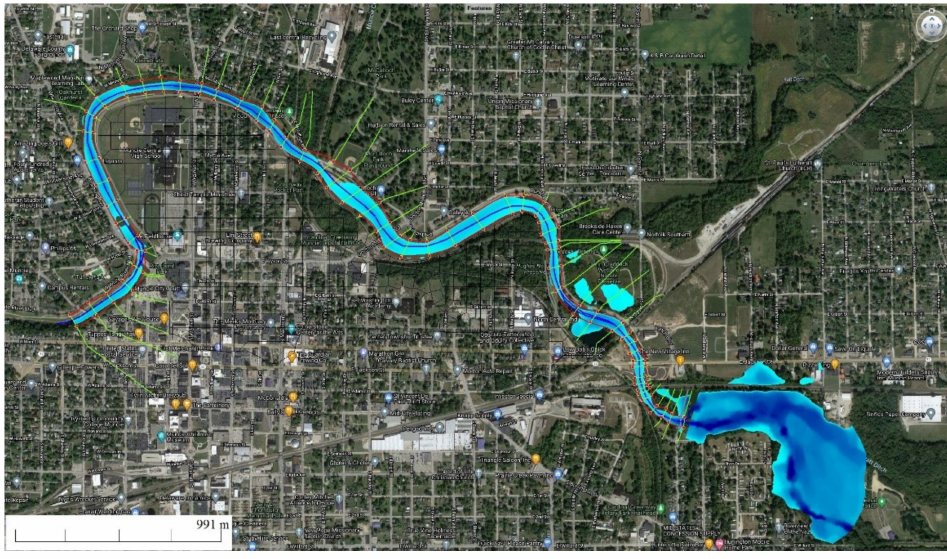
Figure 3. River reach downstream of Muncie with hypothetical reservoir (storage area in blue on lower